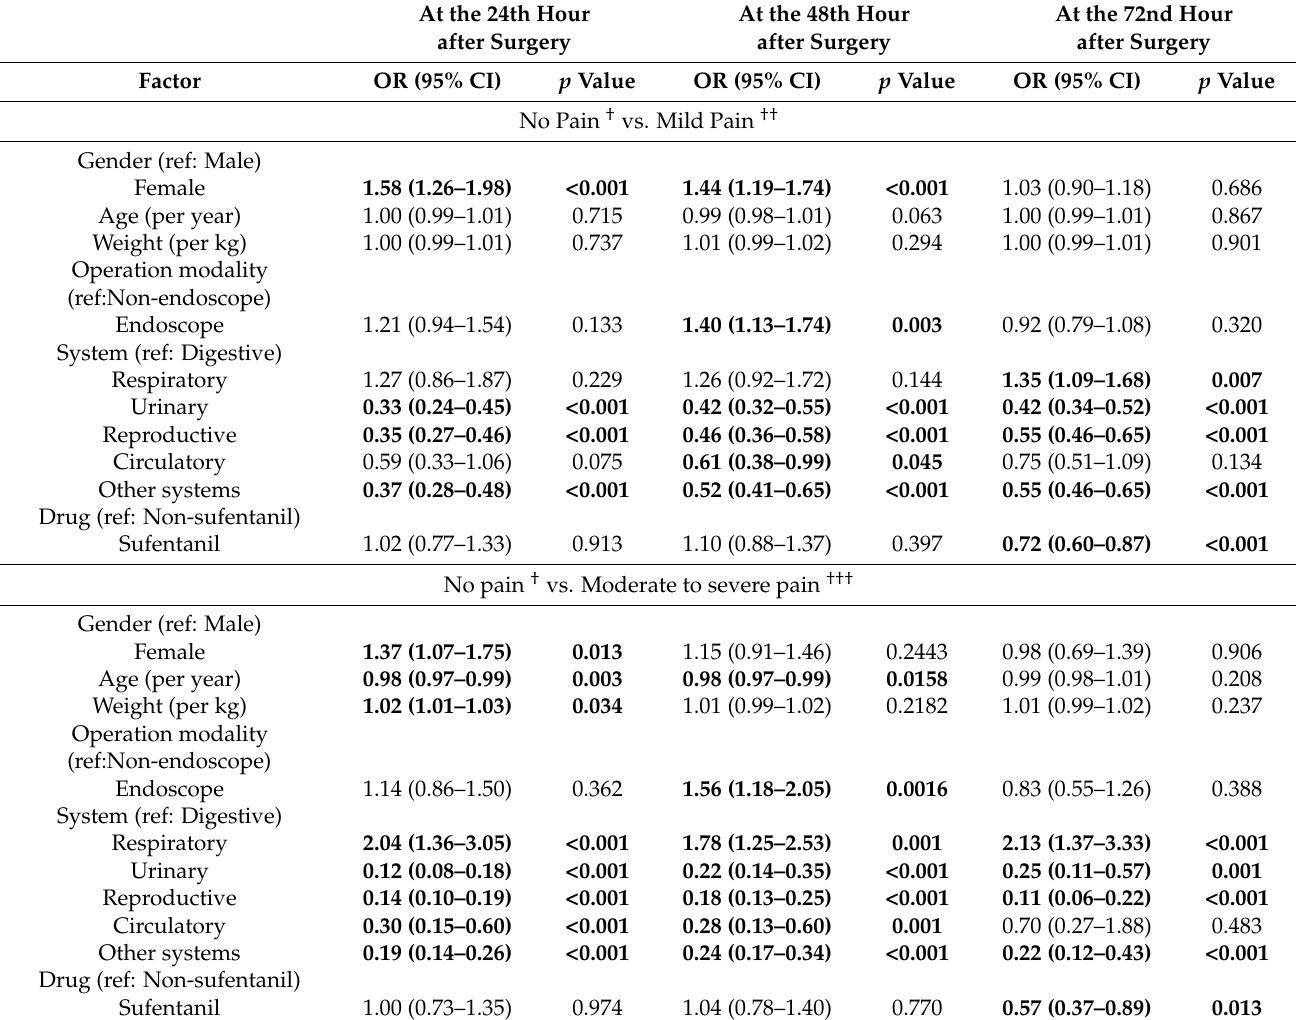
Table 3. Multinominal logistic analysis of factors associated with pain in three pain evaluations. At the 24th Hour after Surgery